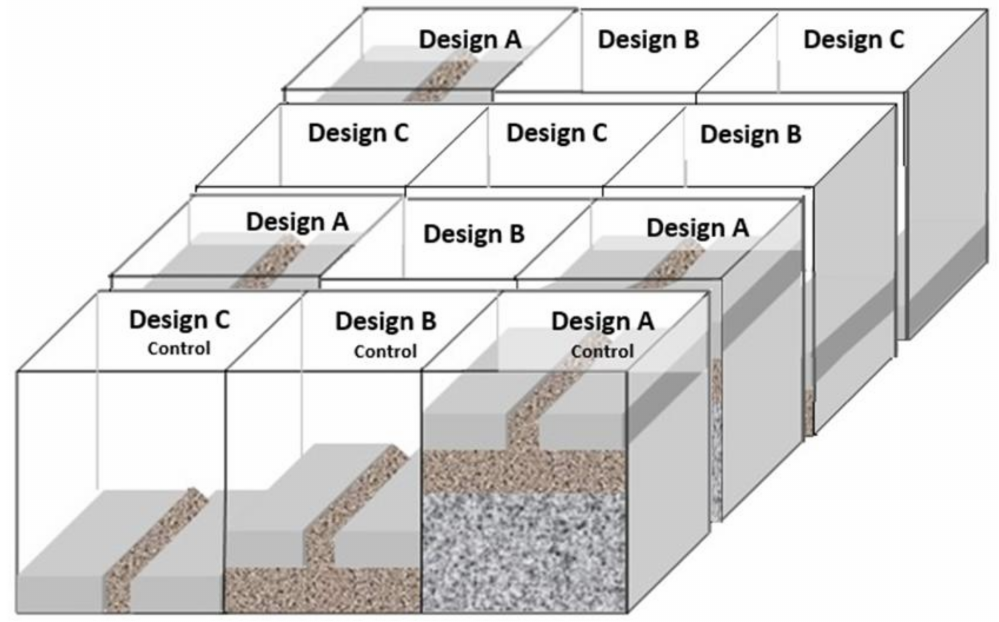
Figure 3. Schematic diagram of the experimental design.